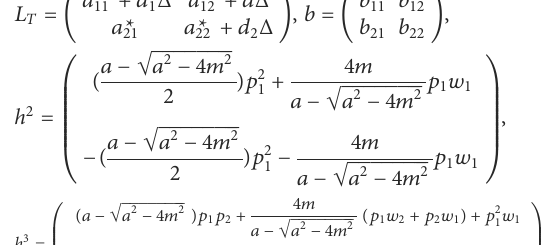
FIGURE 8 Average density of vegetation changes with time t correspondingtodifferentvaluesoftheparameter d (I) d =3.52,(II) d = 4.52, (III) d = 5.52, (IV) d = 6.52, and (V) d = 7.52. The other parameter values are a = 3.25, m = 1.50, d 1 = 1.00, and d 2 =